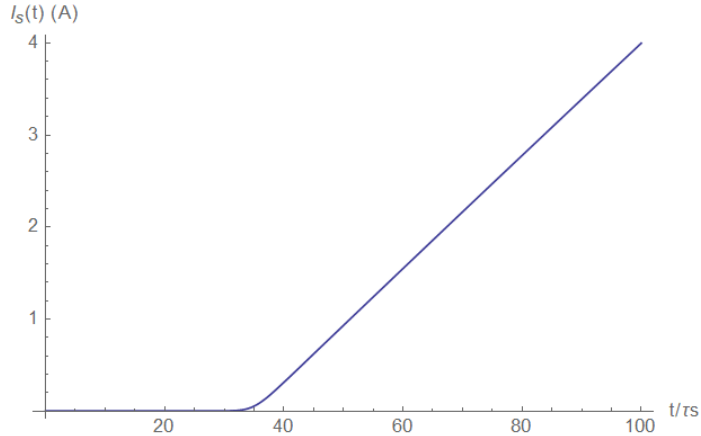
Figure A25. Short current (right after the short).